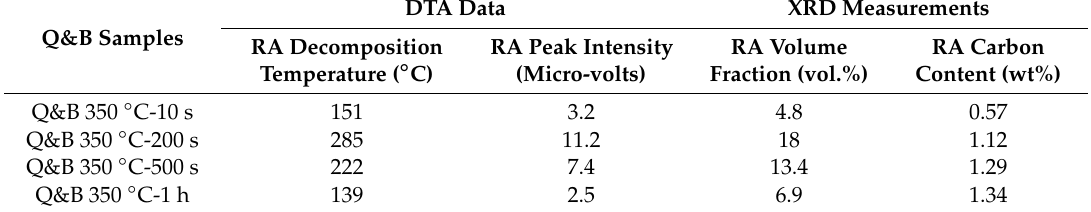
Table 4. The summarized data of DTA for retained austenite decomposition temperature and its peak intensity in conjunction with the associated volume fraction and carbon concentration of various heat-treated samples.